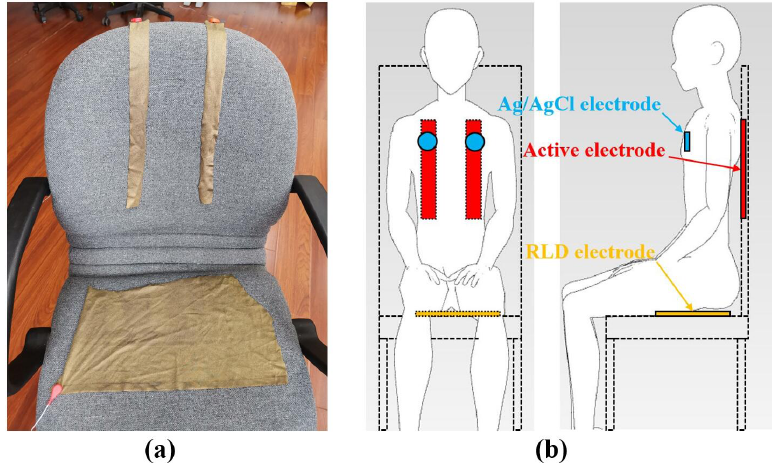
Figure 11. Experimental setups in sitting posture: ( a ) picture, ( b ) schematic.